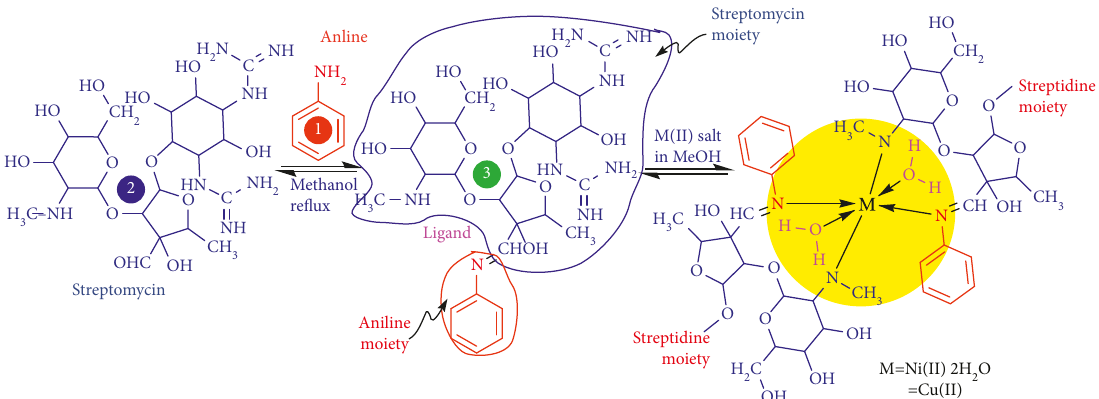
Scheme 1: Synthetic route for the preparation of ligand and metal